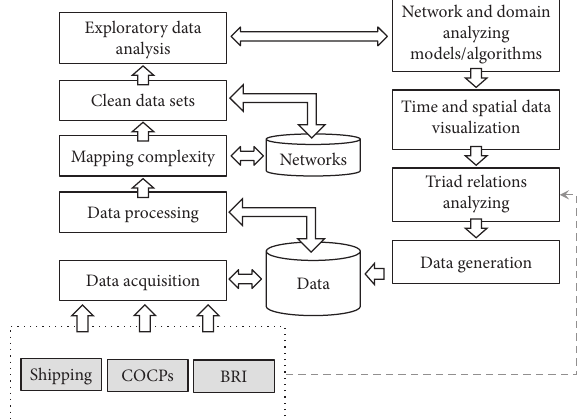
Figure 3: The data-driven analyzing